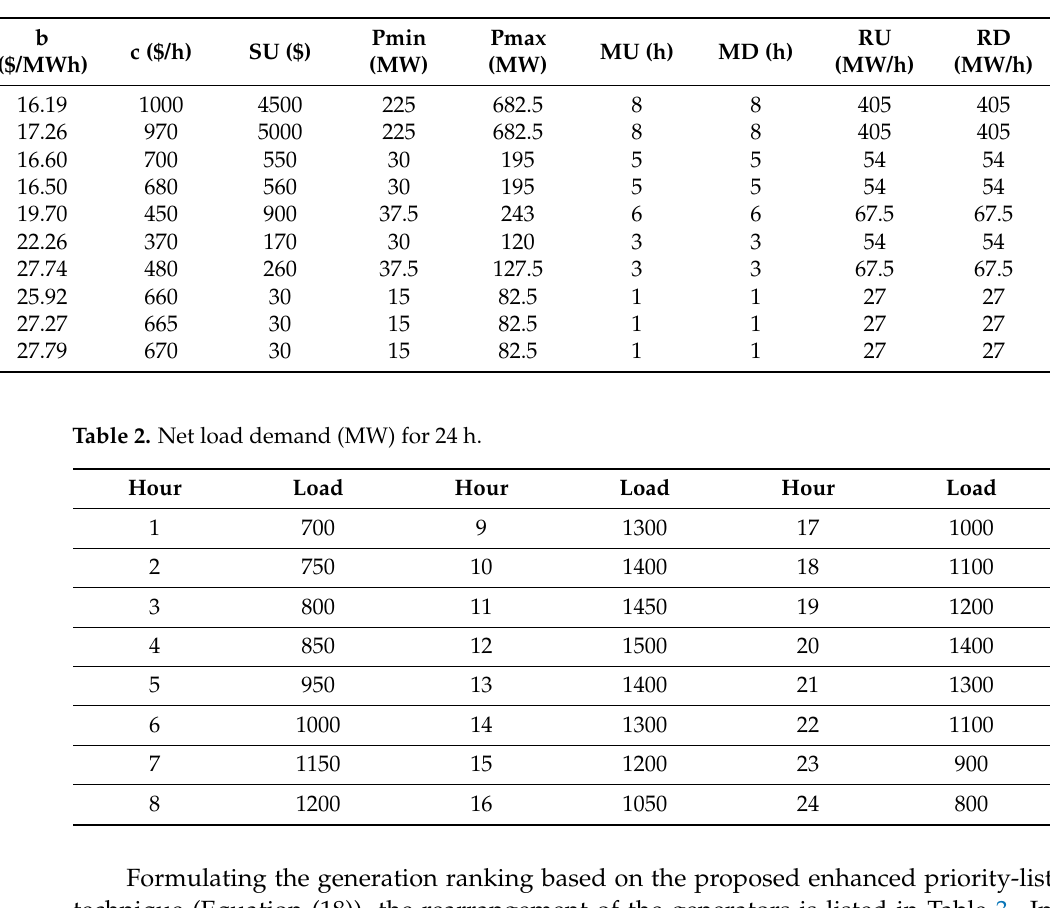
Table 1. Characteristics of the thermal generating units.